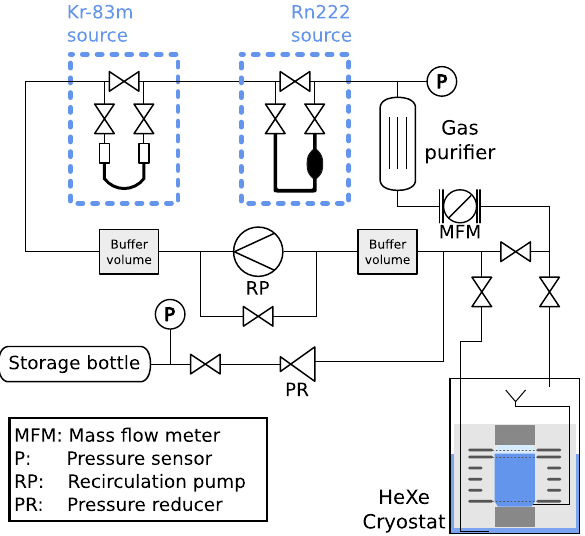
Fig. 6 Simplified scheme of the HeXe gas system used for xenon purification and introduction of gaseous calibration sources